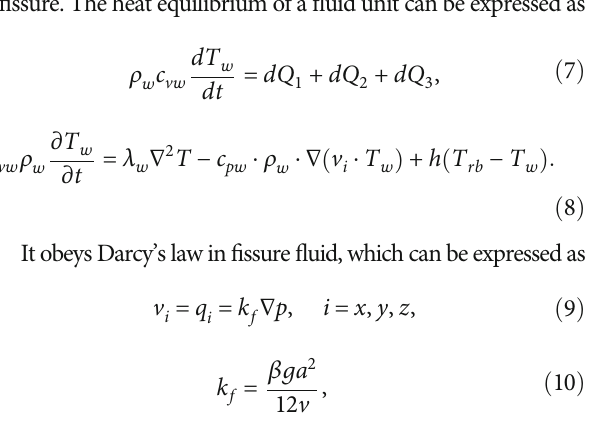
Figure 2: Procedure of fl uid-thermal coupling.